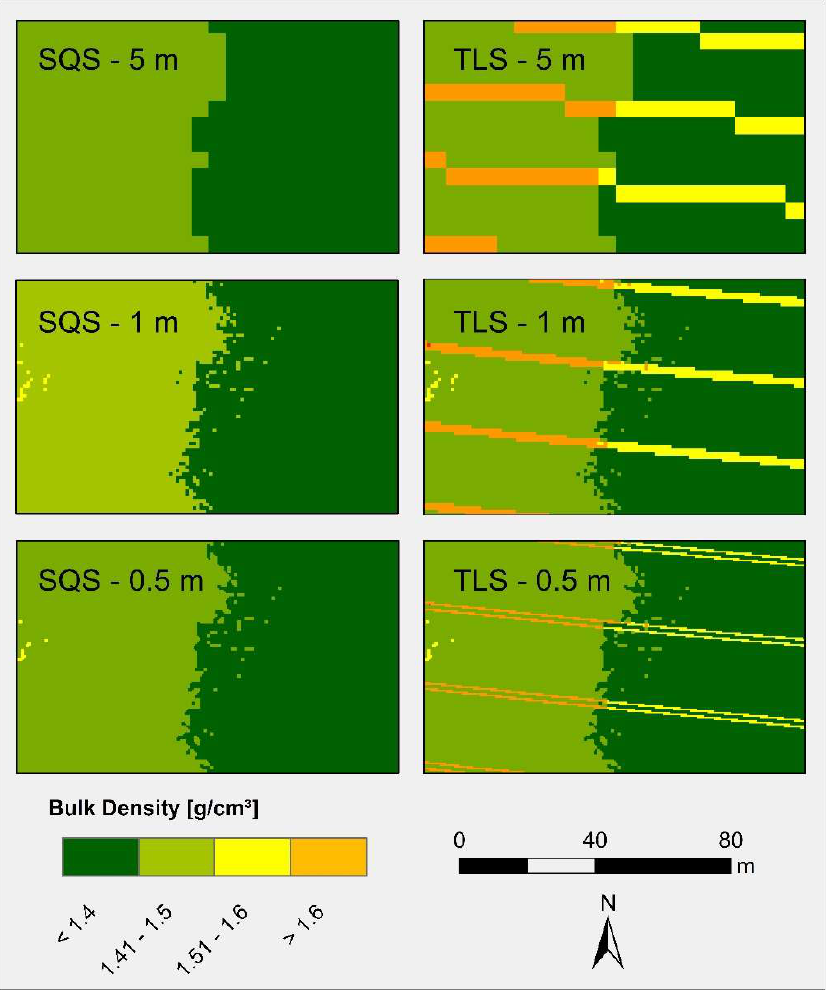
Figure 3. Different spatial resolutions for the Status-Quo-Scenario (SQS; left side) and TramLine-Scenario (TLS; right side) for the input-parameter soil bulk density as example for field C.